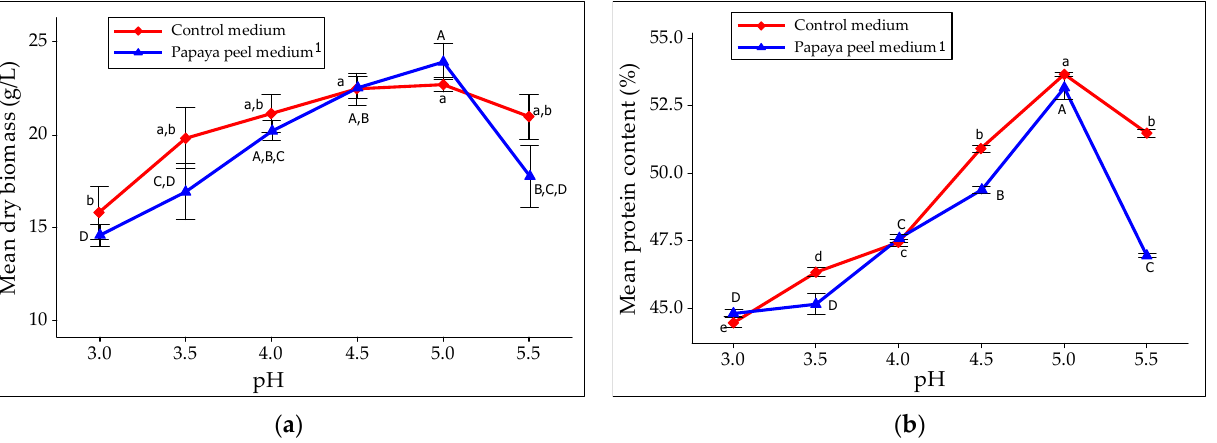
Figure 2. Effect of pH on the dry biomass and protein content of SCP produced from papaya peel and control media using mixed culture of palmyrah toddy in liquid state fermentation at 100 rpm with 10% ( v / v ) substrate concentration at 28 °C for 72 h: ( a ) effect of pH on dry biomass; ( b ) effect of pH on the protein content. Comparisons of mean were performed with Tukey’s multiple comparison test at p < 0.05. Different uppercase and lowercase letters indicate the significant differences in papaya peel medium and control medium, respectively [58].